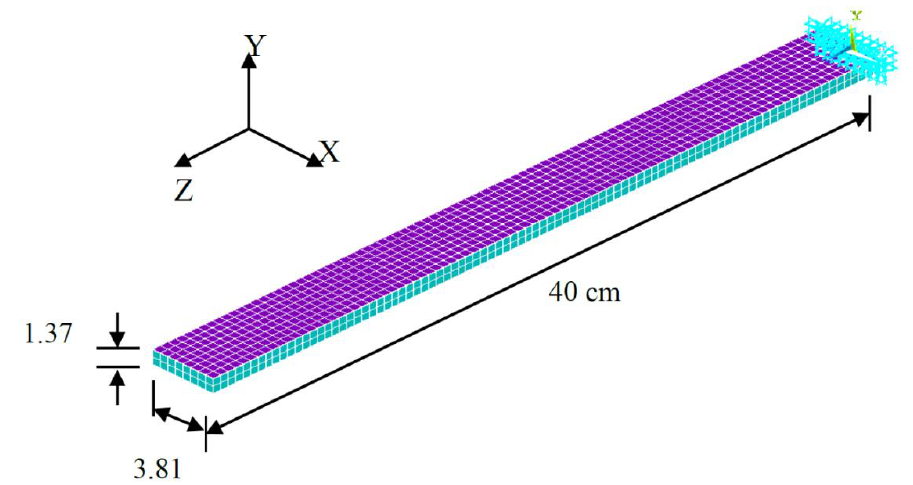
Figure 2. Finite Element mesh used in FEA for the rectangular sandwich cantilever beam.